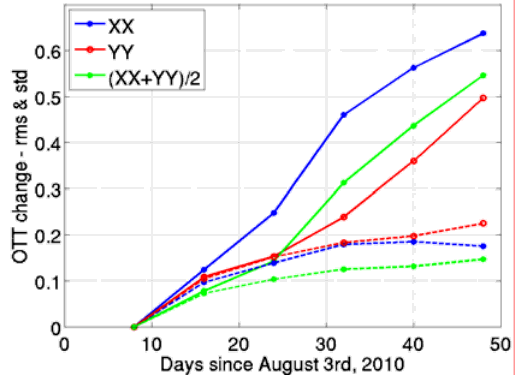
Figure 7. Evolution of the averaged rms of the Ocean Target Transformation (OTT) mismatches as a function of the number of days following the FTR calibration, for both T and T , and the First Stokes parameter divided by two. Dashed lines correspond to the Y averaged standard deviation. (Figure 3 from